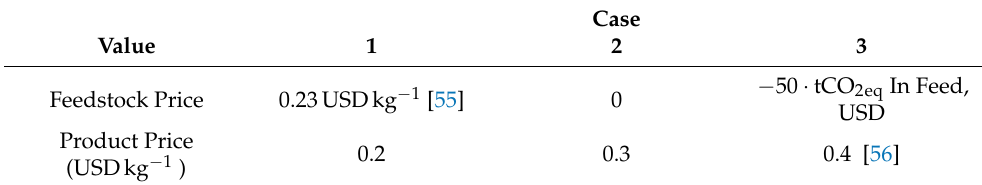
Table 3. Our model evaluates the payback period and the net return after 10y, considering feedstock and product prices variation.